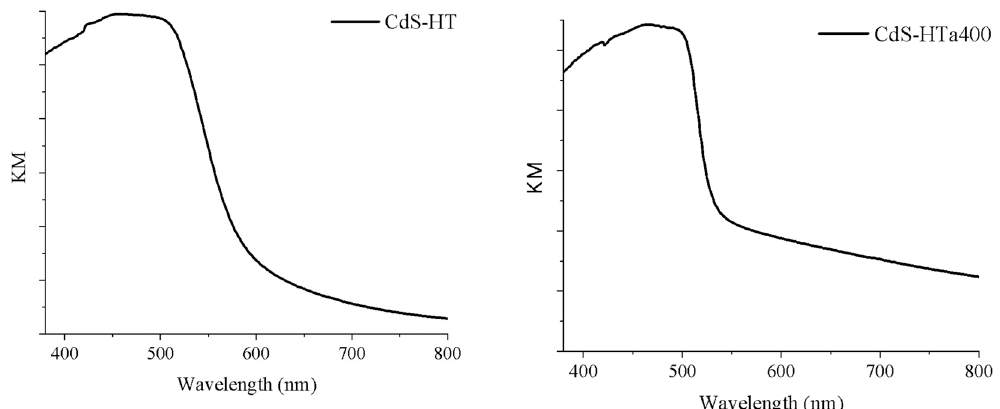
Figure 6. Absorption spectra of CdS-HT and of CdS-HTa400.